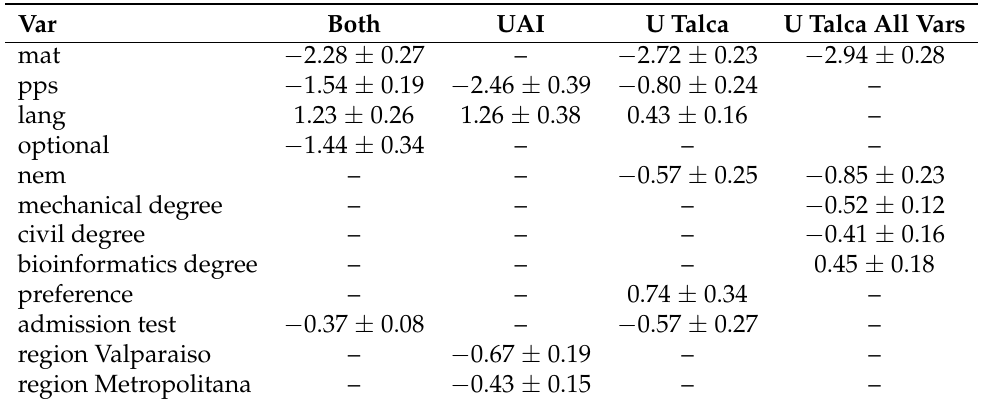
Table A2. Learned parameters for the logistic regression for all datasets, parameters with p -value over 0.01 are not